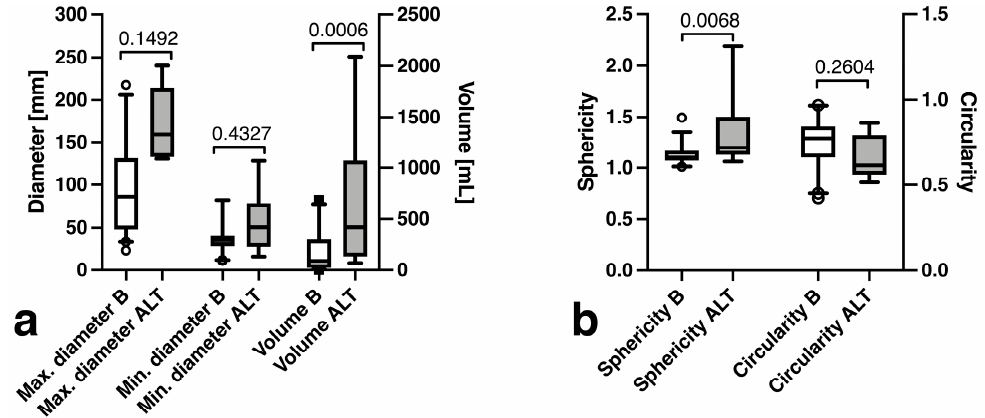
Figure 1. Box plots comparisons of ( a ) maximum/minimum diameters and volume and ( b ) sphericity and circularity of benign (B) tumors and atypical lipomatous tumors (ALT).